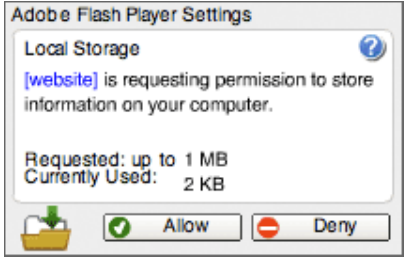
Fig. 1. Additional storage space requirements dialog shown by Adobe Flash plugin, providing information about current and requested storage data